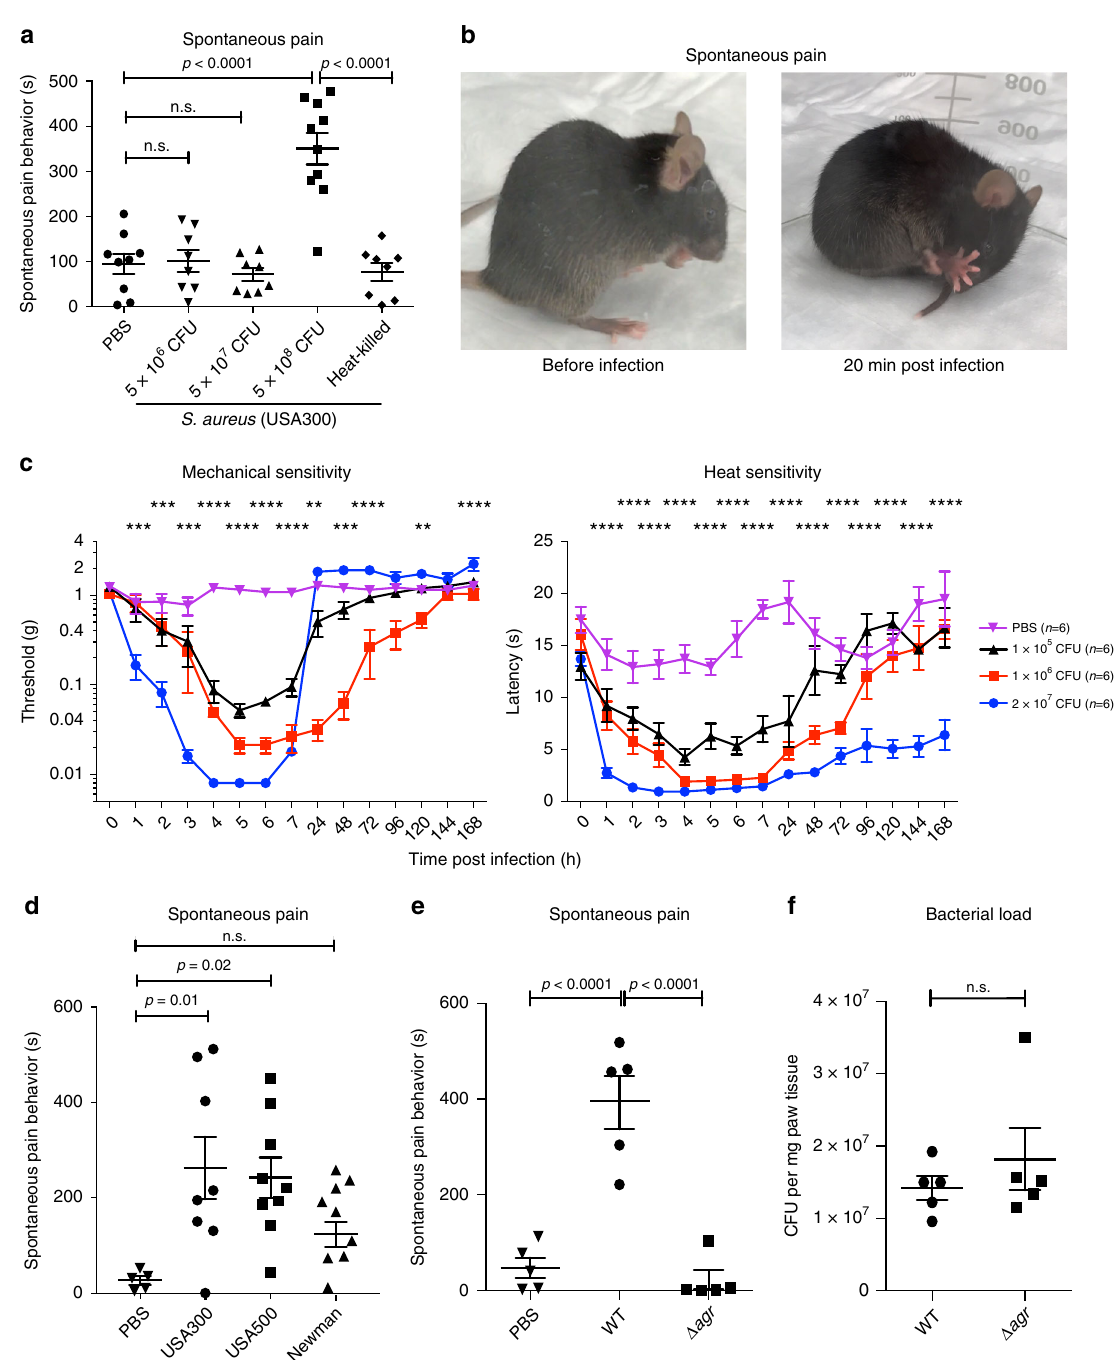
Fig. 1 Methicillin-resistant S. aureus infection induces dose-dependent spontaneous pain and mechanical and heat hyperalgesia. a S. aureus infection (MRSA strain USA300) induces dose-dependent spontaneous pain re fl exes (lifting/licking/ fl inching behaviors) in mice measured over 60 min post infection (5 × 10 6 , n = 8 mice per group; 5 × 10 7 , n = 8 mice per group; 5 × 10 8 , n = 10 mice per group CFU). By contrast, heat-killed bacteria (5 × 10 8 CFU), n = 8 mice per group does not produce spontaneous pain. PBS control, n = 9 mice per group. b Representative images of a mouse before (left) and 20 min after infection (right) with 5 × 10 8 CFU of S. aureus . c S. aureus (USA300) induces dose-dependent mechanical hyperalgesia (assayed by von Frey fi laments) and heat hyperalgesia (assayed by the Hargreaves ’ test) measured over 168 h post infection. Two-way ANOVA with Tukey ’ s post-tests comparing PBS vs. 2 × 10 7 CFU S. aureus : ** p < 0.01; *** p < 0.001; **** p < 0.0001. n = 6 mice per group. d Spontaneous pain induced by injection with PBS or 5 × 10 8 CFU of different S. aureus strains (methicillin-resistant strains USA300 and USA500, or methicillin-sensitive strain Newman). PBS, n = 5; USA300, n = 7; USA500 and Newman, n = 8 mice per group. e Spontaneous pain re fl exes induced by PBS, USA300 (WT), or USA300 isogenic mutant bacteria lacking the agr system ( Δ agr ). Pain depends on the presence of agr . n = 5 mice per group. f Bacterial load recovery from mice infected by WT or Δ agr USA300 1 h post infection. n = 5 mice per group. a , d N = 3 replicates; c , e , N = 2 replicates; f , N = 1 replicate. a – f Symbols represent individual mice. Statistical comparisons by one- way ANOVA with Tukey ’ s post-tests. Error bars throughout fi gure, mean ±